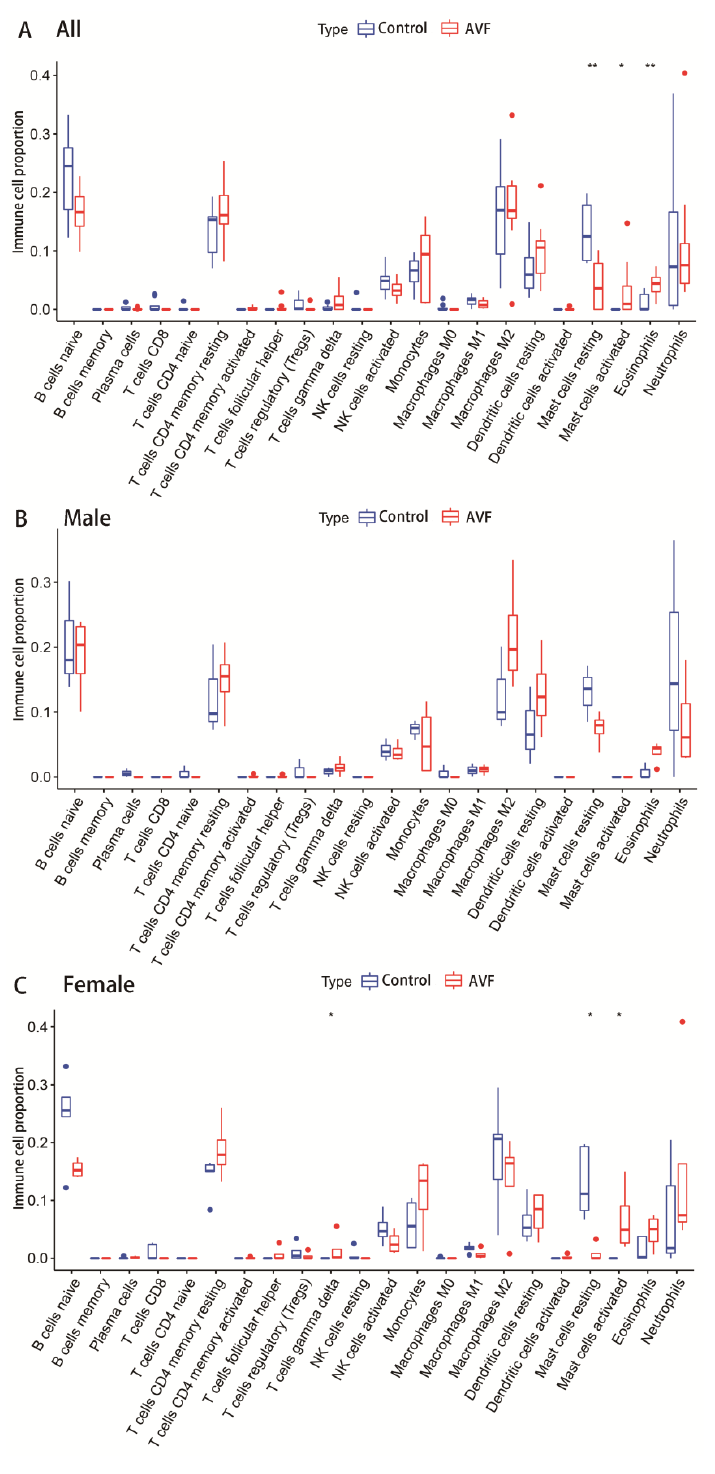
Figure 9. Box plots demonstrating the difference of infiltrated immune cells. ( A ) Box plot of immune cell infiltration differences in AVF patients. ( B ) Box plot of immune cell infiltration differences in male AVF patients. ( C ) Box plot of immune cell infiltration differences in female AVF patients. Significant differences are indicated by * p < 0.05 ;** p < 0.01